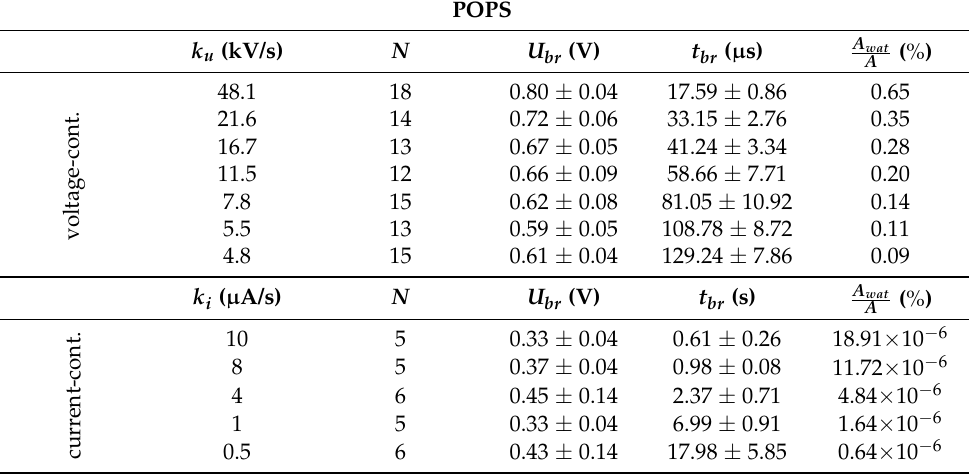
Table 3. Results for planar lipid bilayers composed of POPS. In the upper part of the table, the results of voltage-controlled measurements with seven different slopes k u are gathered while the results of current-controlled measurements with five different slopes k i are presented in the lower part of the table. For each slope of linearly rising signal the planar lipid breakdown voltage U br and lifetime t br are presented. Values are given as means ± standard deviations. A wat fraction of the planar lipid bilayer that is occupied by pores. N is the number of experiments in each experimental group.